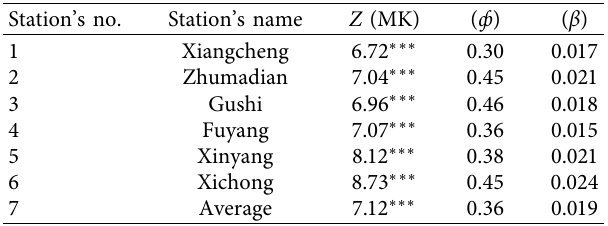
Table 1: Z-statistic results of MK, ITA ( ф ), and Sen’s slope esti- mator test ( β ). Station’s